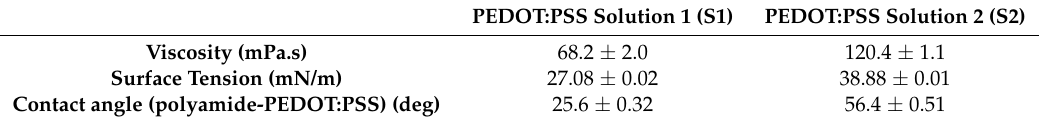
Figure 7. Surface tension illustration. Table 1. Measured physical properties of PEDOT:PSS solutions.